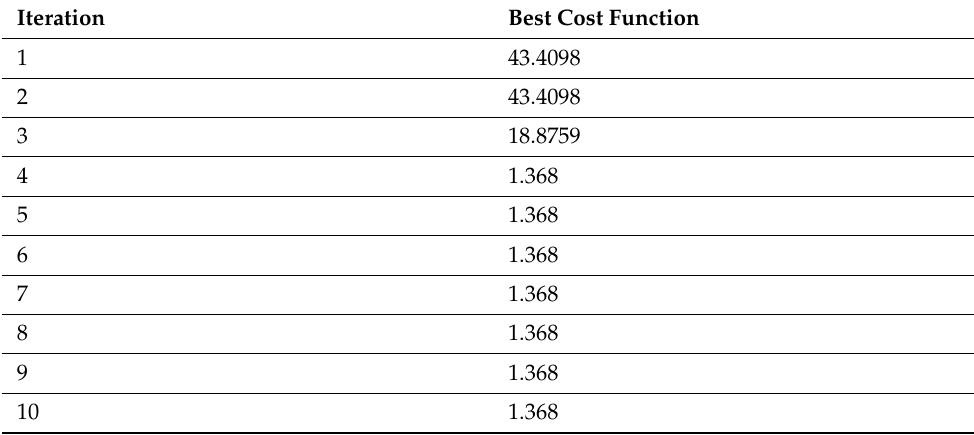
Table 2. Best function during the process of the PSO – ANN.